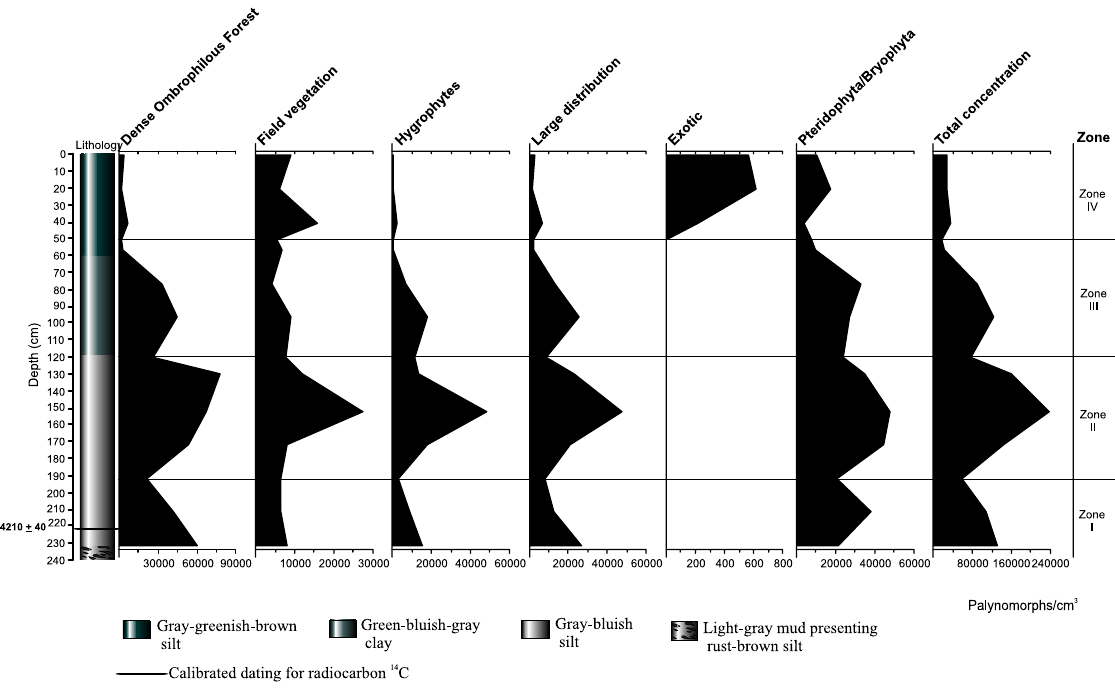
Fig. 7 – Concentration palynodiagram (variable values of scales) of the ecological groups recognized in the analysis of the core from Guanabara